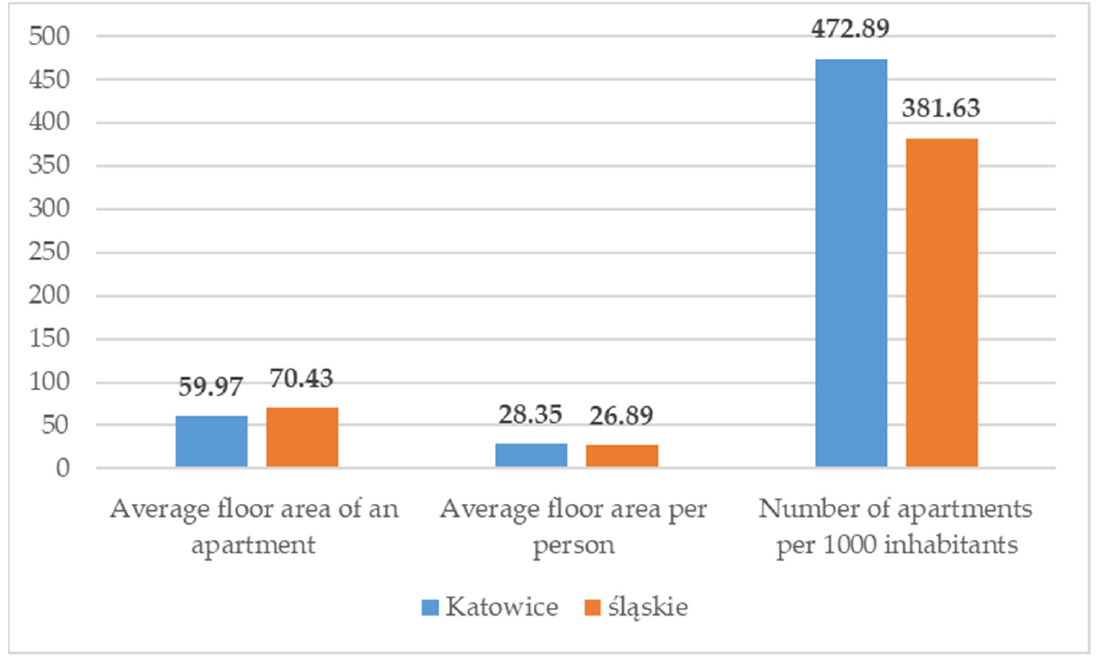
Figure 6. Indicators of housing infrastructure availability in Katowice and the Silesian Province.